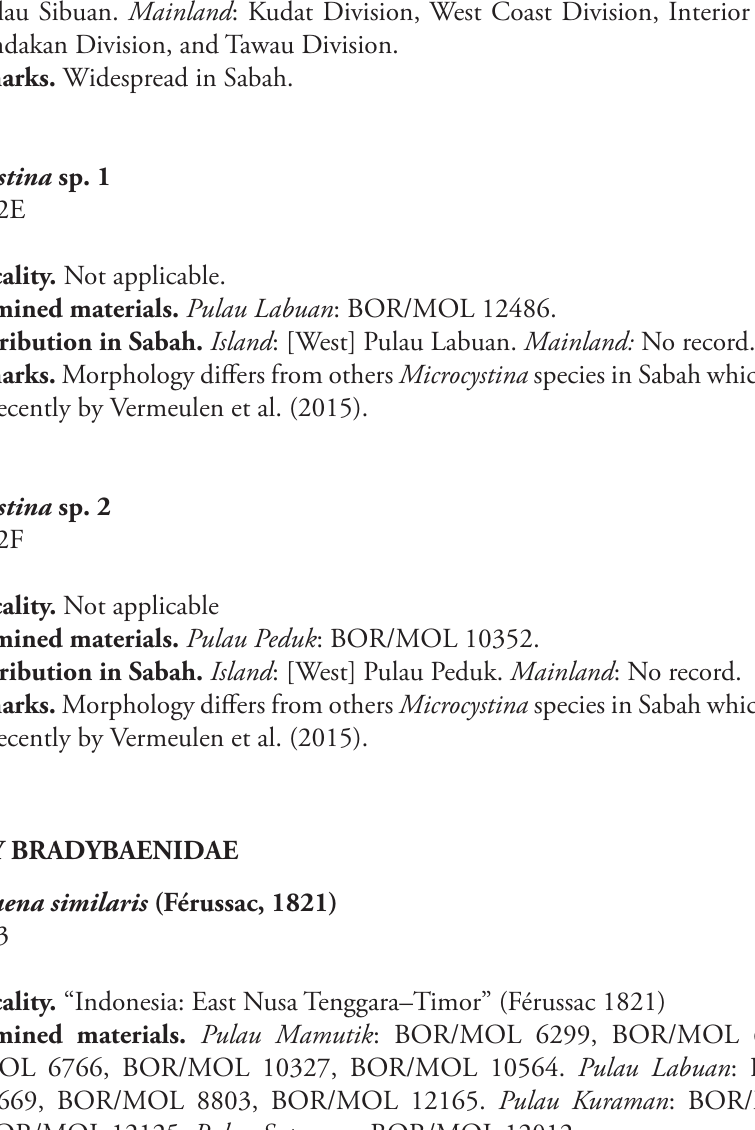
Type locality. “Indonesia: East Nusa Tenggara–Timor” (Férussac 1821) Examined materials. Pulau Mamutik : BOR/MOL 6299, BOR/MOL